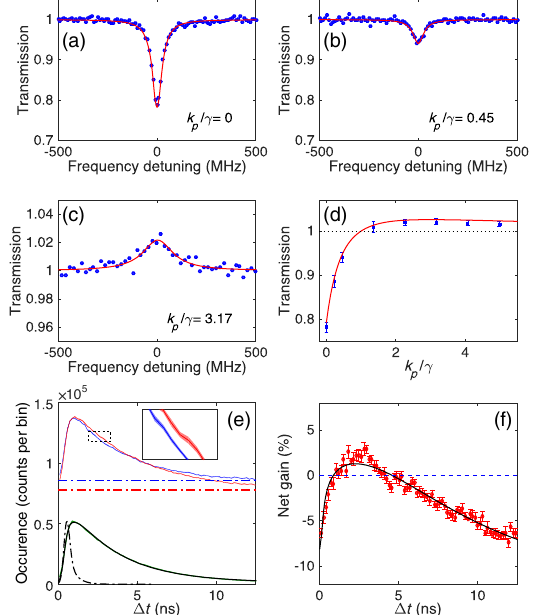
FIG. 5. (a) – (c) Coherent resonant response (transmission) of the cavity-molecule system as a function of the probe laser frequency. In each case, the pump rate k is indicated in the p legend. (d) Amplification as a function of pump power. (e) The green curve shows the emission of a molecule in response to a picosecond pulse in the absence of the probe laser. The black curve presents a fit, taking into account the instrumental response displayed by the dash-dotted black profile. The red and blue curves show the time evolution of the emission on the 00ZPL when the probe laser is on and away from the molecular resonance, respectively. The dash-dotted red and blue horizontal lines mark the background from the probe laser light for the on- and off-resonance cases, respectively. The shaded areas in the inset zoom correspond to the standard error of the occurrences at each delay time. (f) The net change due to stimulated emission obtained by subtracting the red and blue curves in (e) and normalizing to the intensity of the probe laser. The error bars represent the standard error of the mean at each delay time. The solid curve displays a fit according to analytical calculations. See Supplemental Material for details